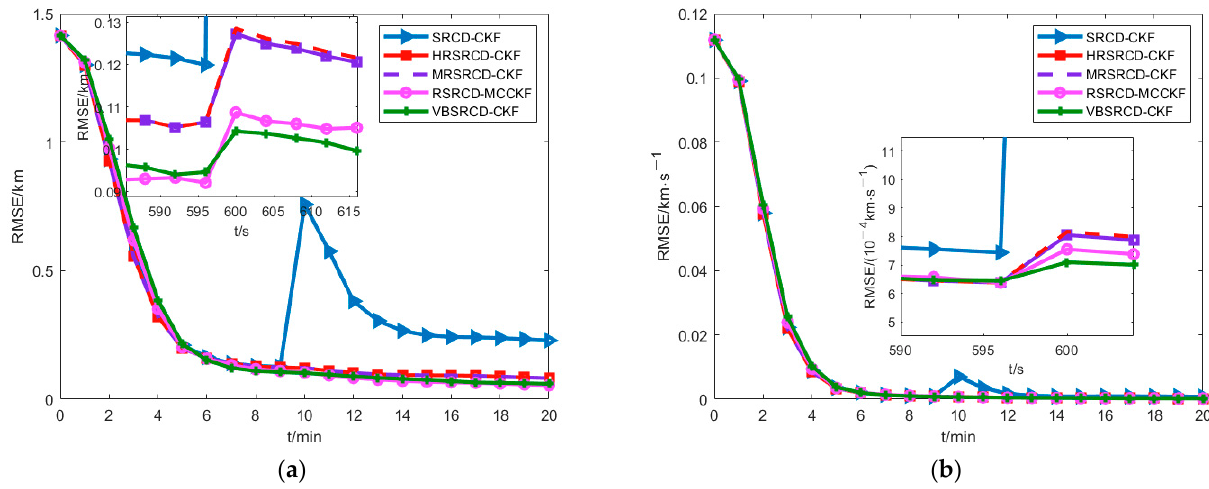
Figure 4. The RMSE comparison of each algorithm under abnormal measurement. ( a ) RMSE pos of each algorithm under abnormal measurement; ( b ) RMSE vel of each algorithm under abnormal measurement.